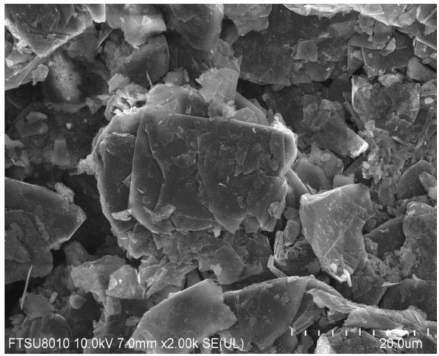
Figure 2. SEM image of flake